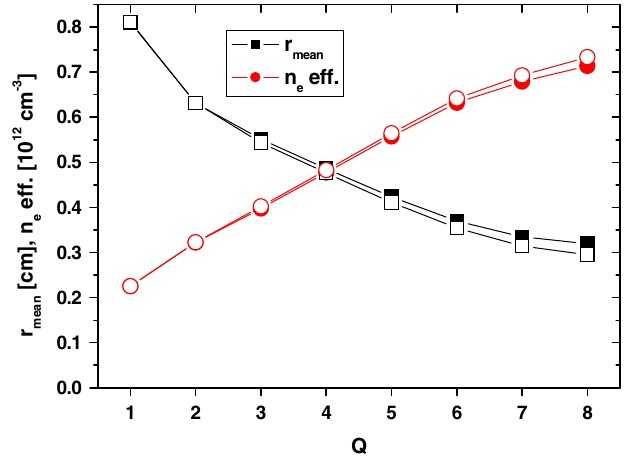
FIG. 12. (Color) Mean radius of the ion beam at the plasma electrode (squares) and effective electron density (circles) for the neon ions with different charge states. Open symbols are for the 22 Ne ions, solid ones are for 20 Ne